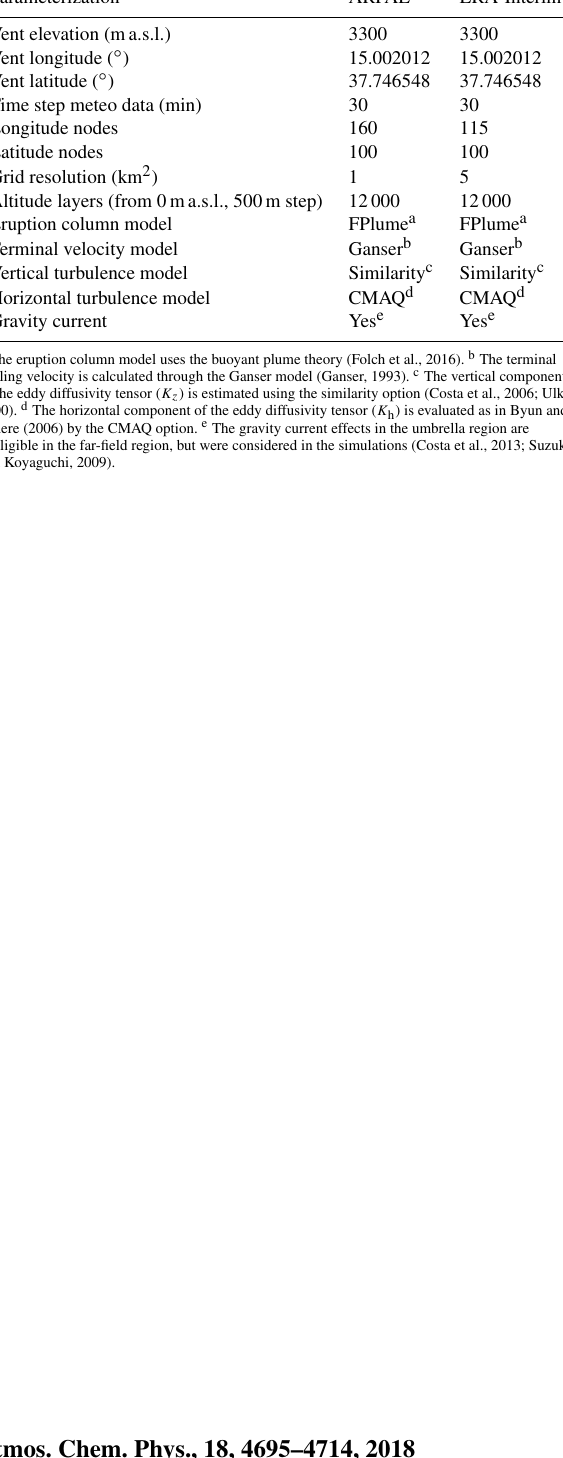
Table A1. Additional parameterizations used in the simulations. Parameterization